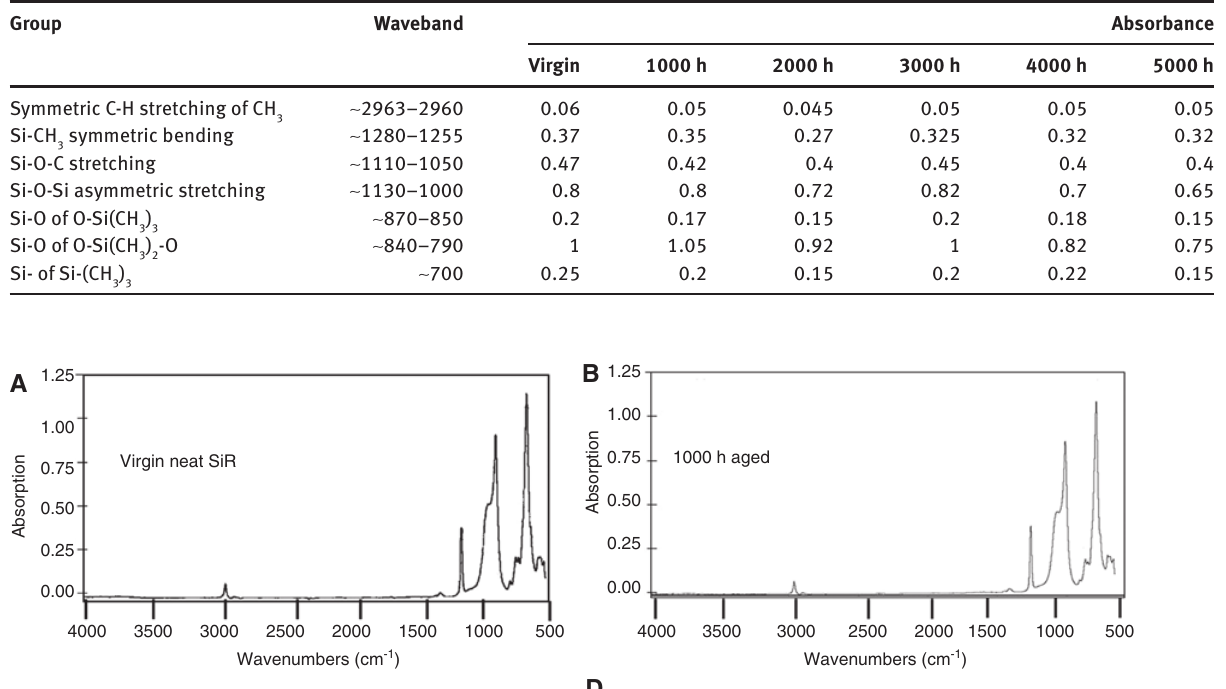
Table 4: Absorption peaks in neat SiR from virgin to 5000 h.